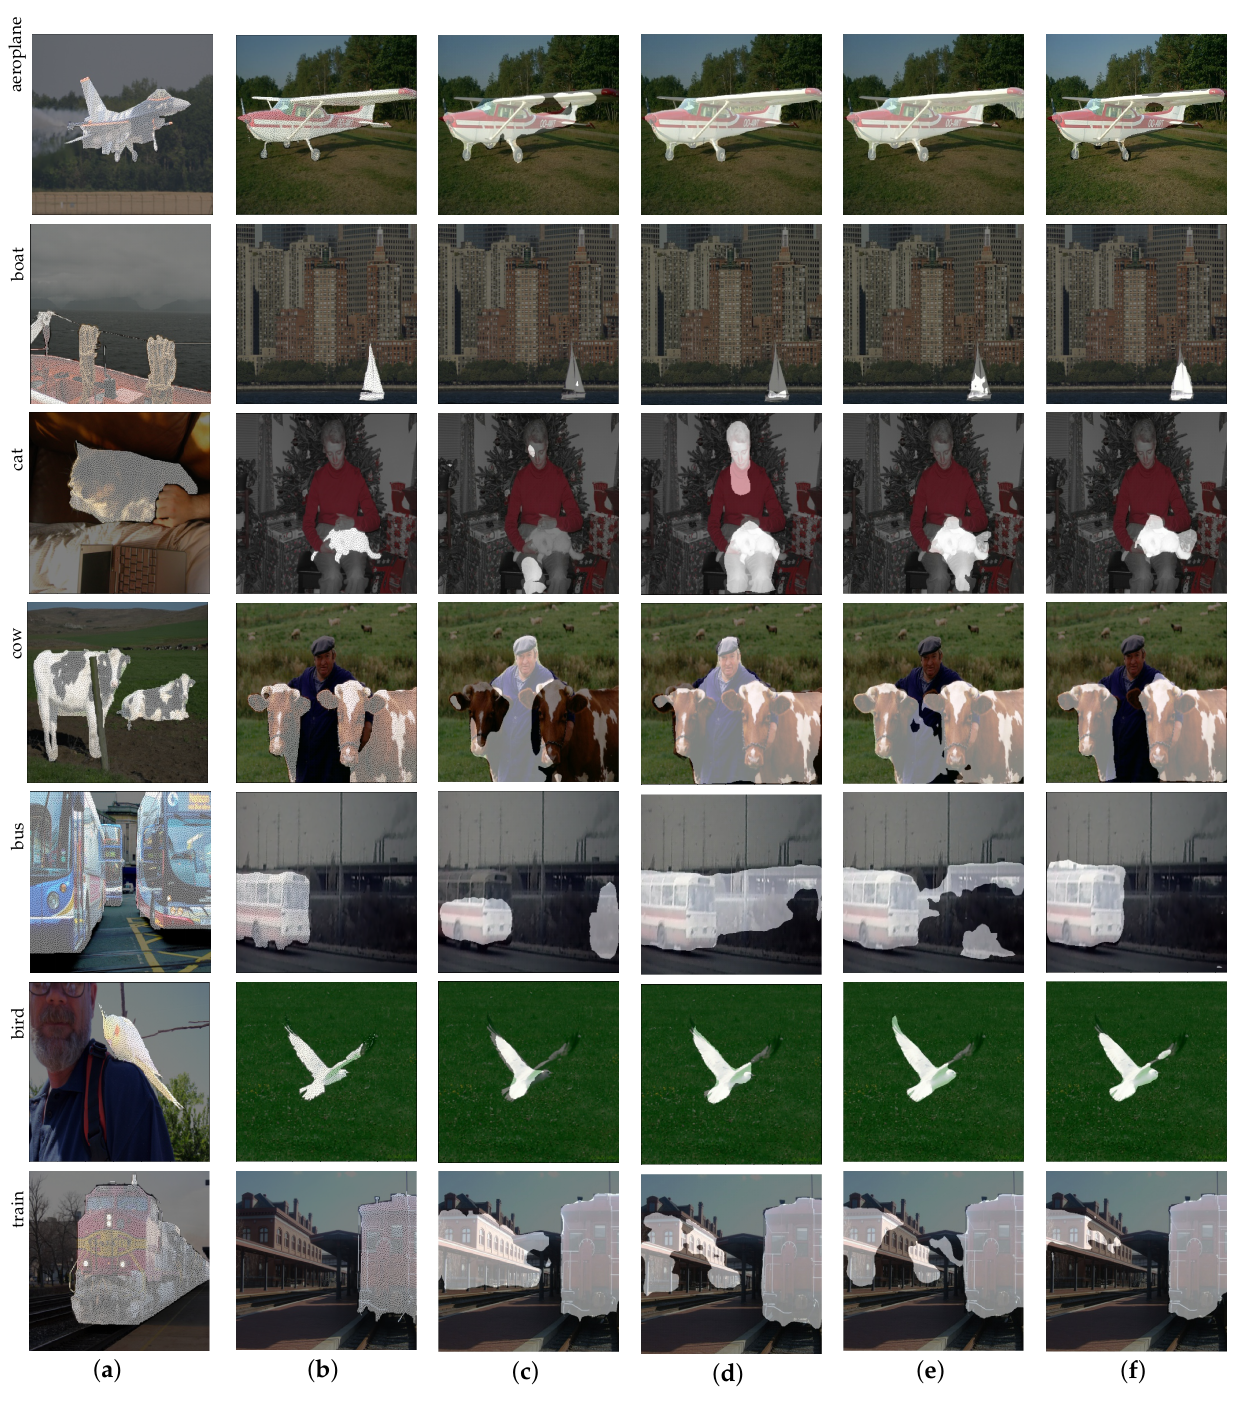
Figure 6. Qualitative segmentation results in 1-way 1-shot segmentation on PASCAL-5 i . Specifically, the first column is the support images with ground-truths, the second column is the query images with ground-truths, and the third, fourth, fifth, and sixth columns are the segmentation results of the query images obtained by CANet, ASGNet, PFENet, and MCEENet, respectively. ( a ) support; ( b ) ground-truth; ( c ) CANet; ( d ) ASGNet; ( e ) PFENet; ( f )